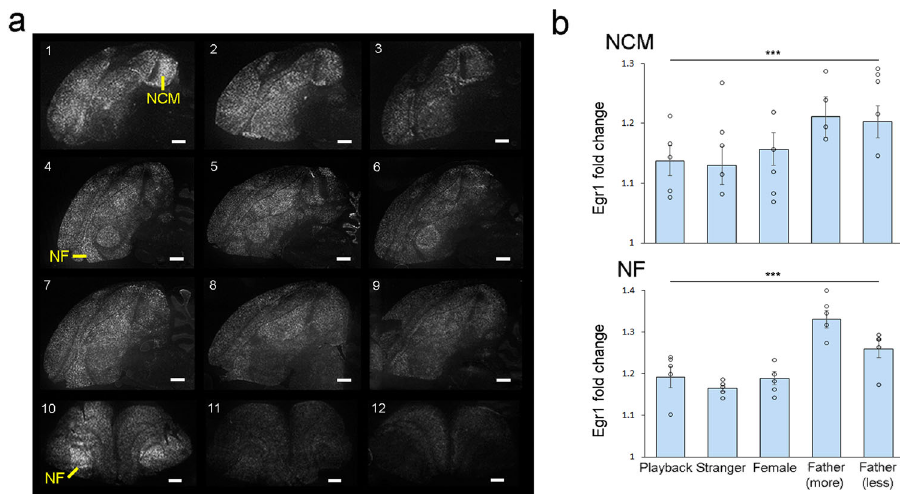
Fig. 4 The listening approaching behavior of juvenile zebra fi nches was associated with speci fi c forebrain regions. Neural activity-dependent marker, Egr1 , was used to identify the associated forebrain region ( a1 – a9 ). Sagittal view shows higher Egr1 mRNA expression in the caudal medial nidopallium (NCM) of juveniles in response to the father tutor ’ s song ( a1 ), compared to the playback of the tutor song ( a2 ), and singing of a stranger adult ( a3 ). singing, regardless of the amount of juvenile singing ( a4, a7 ), compared to the juvenile siblings who showed a lower approaching rate toward father